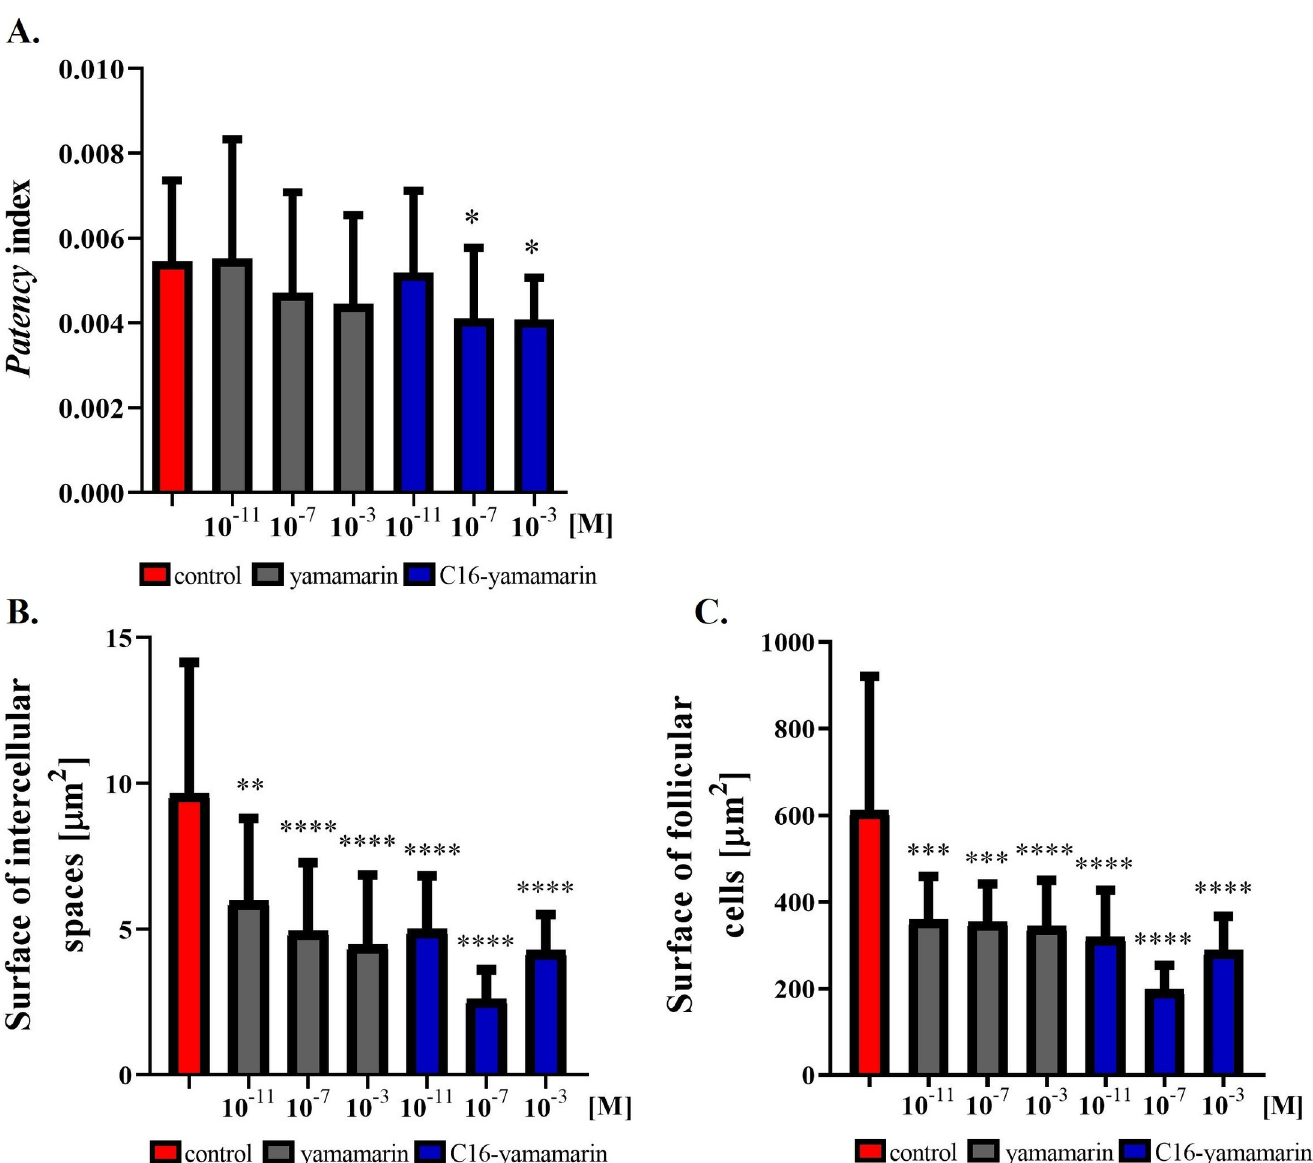
Fig 6. Patency index (A), surface of intercellular spaces (B) and surface of follicular cells. Statistically significant differences (one-way ANOVA with Dunn’s multiple comparisons test) in comparison to the control are indicated by asterisks p � 0.1 ( � ), p � 0.01 ( �� ), p � 0.001 ( ��� ), p < 0,0001 ( ���� ), n � 26.